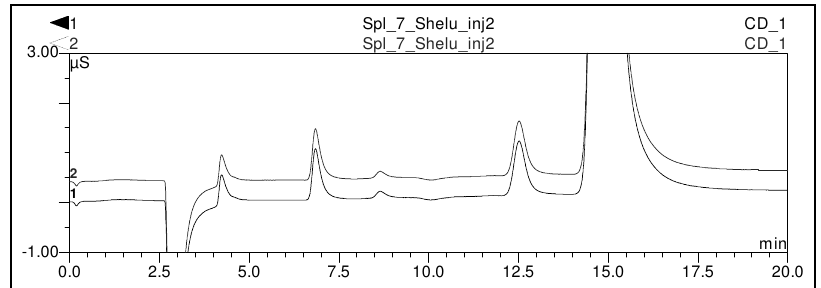
Figure 9. Electrochemical (amperometry) detection of sample_7_Shelu for arsenite content (duplicate injections)